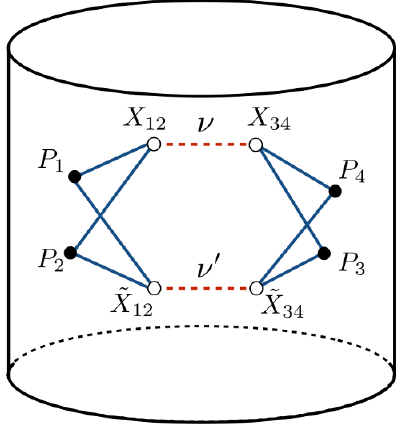
Figure 3 . The diagrammatic expression of (5.10). The white circles are bulk points and the black circles are boundary